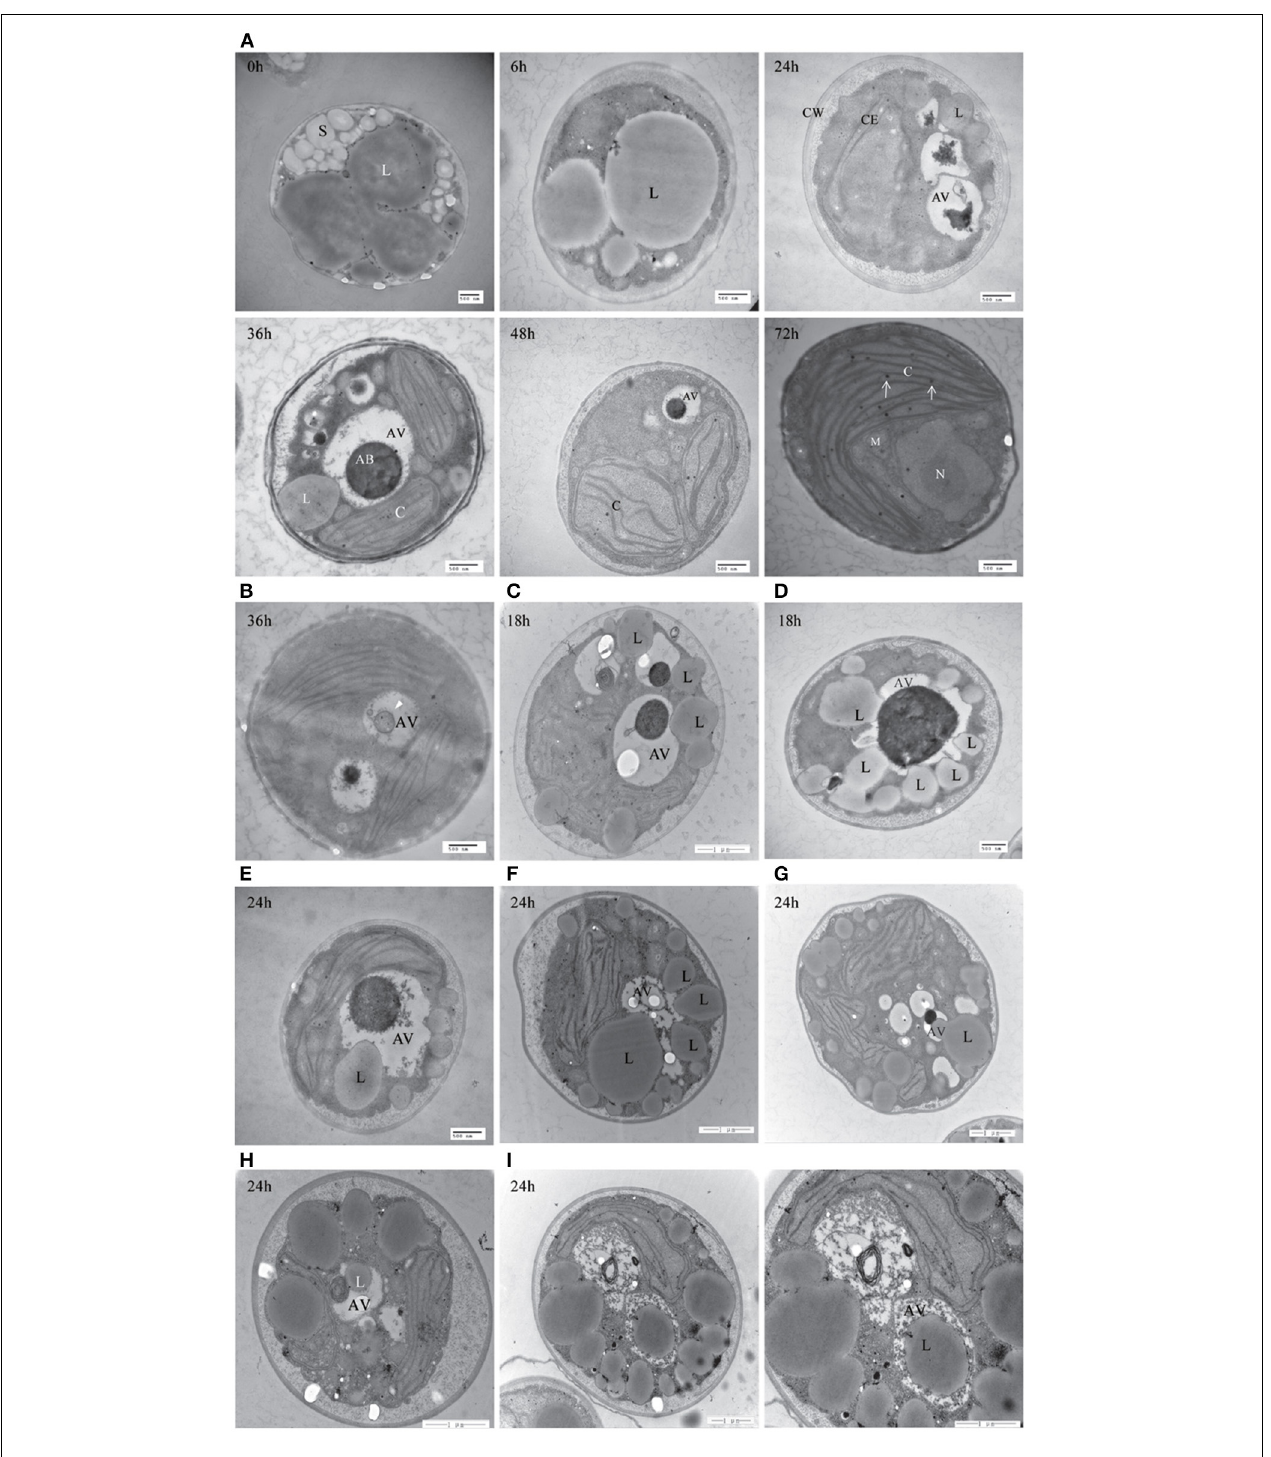
FIGURE 9 | Transmission electron microscope (TEM) images of A. protothecoides during the HA transition. (A) Heterotrophic cells were resuspended in autotrophic medium for the indicated time and then processed for TEM. C, chloroplast; CE, chloroplast envelope; CW, cell wall; S, starch granules; L, lipid bodies; AV, autophagic vacuoles; AB, autophagic bodies; M, mitochondria; N, nuclear. White arrows indicate plastoglobuli in